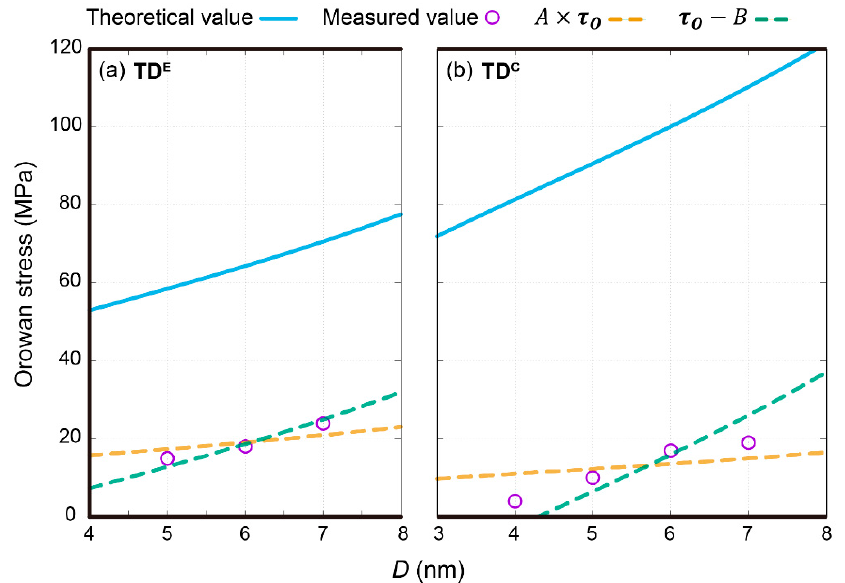
Figure 4. The comparison between theoretical values given by the equation of BKS model, measured values, and modified values of Orowan stress for TD of ( a ) (cid:4668)101(cid:3364)2(cid:4669) extension twin and ( b ) (cid:4668)101(cid:3364)1(cid:4669) compression twin.